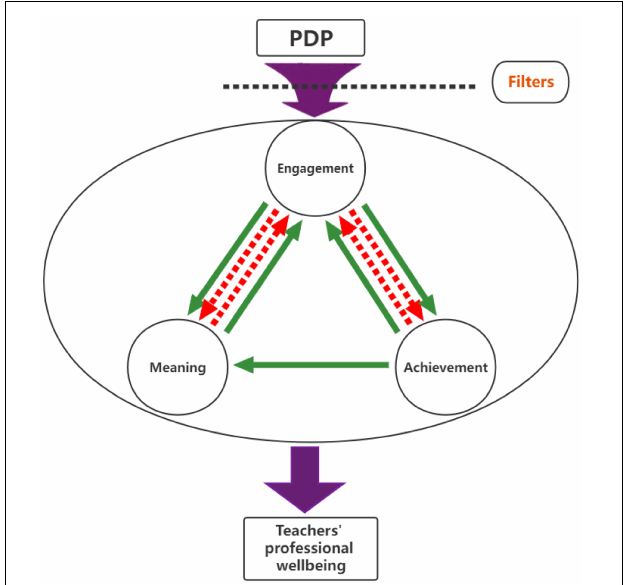
FIGURE 5 | Indicators that triggered the change in teachers’ professional